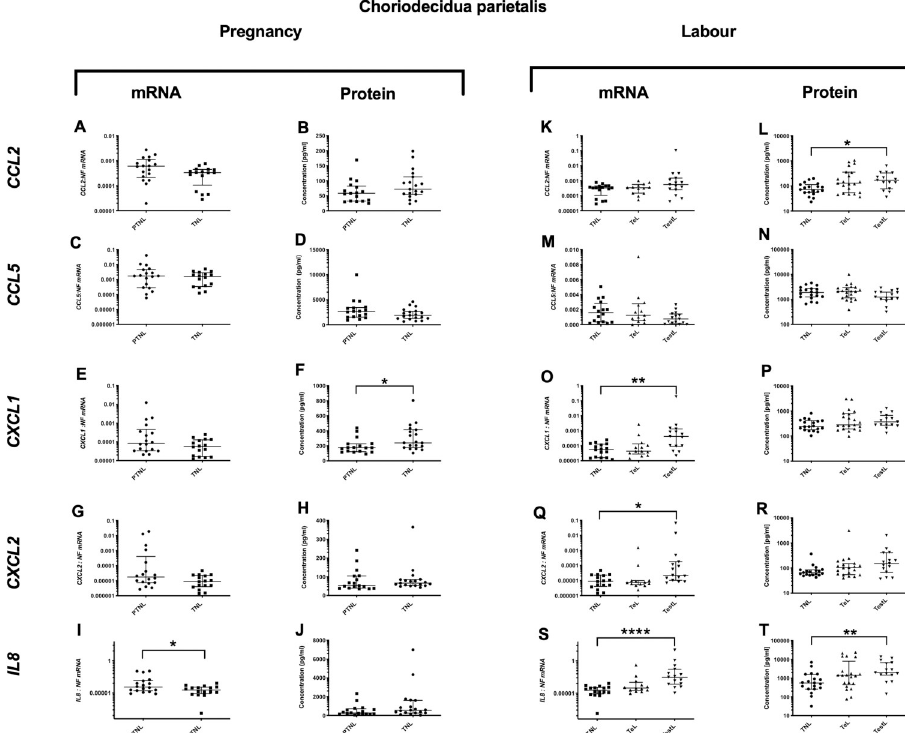
Fig 9. Chemotactic cytokine changes in the choriodecidua parietalis. The cytokine levels in the choriodecidua parietalis samples obtained from four groups of women (mean gestational age ± SD in each case), PTNL (33.8 ± 1.7weeks, n = 17), TNL (39.3 ± 0.8 weeks, n = 19), TeL (38.4 ± 1.3weeks, n = 21) and TestL (39.5 ± 1.0, n = 15) were compared. Tissue levels of the cytokines were quantified using Bio-plex human cytokine 19-plex-array kit (Bio-rad) and a separate assay for CCL5 as describe in Materials and Methods . A subset of choriodecidua parietalis samples, PTNL (33.8 ± 1.7 weeks, n = 17), TNL (39.3 ± 0.9 weeks, n = 16), TeL (38.6 ± 1.2 weeks, n = 13) and TestL (39.5 ± 1.0, n = 15) were used to compare the mRNA expression using rtPCR of CCL2 , CCL5 , CXCL1 , CXCL2 and IL-8 . Normally distributed data were analysed using a Student’s t-test for two groups and an ANOVA followed by a Dunnett’s or Bonferroni’s post-hoc test for three groups or more. Data that were not normally distributed were analysed using a Mann Whitney test for 2 groups and when comparing three groups or more a Friedman’s test, with a Dunn’s multiple comparisons post-hoc test. The data are shown as median with interquartile range. The p values are demonstrated by � is p < 0.05 and �� is p < 0.01.